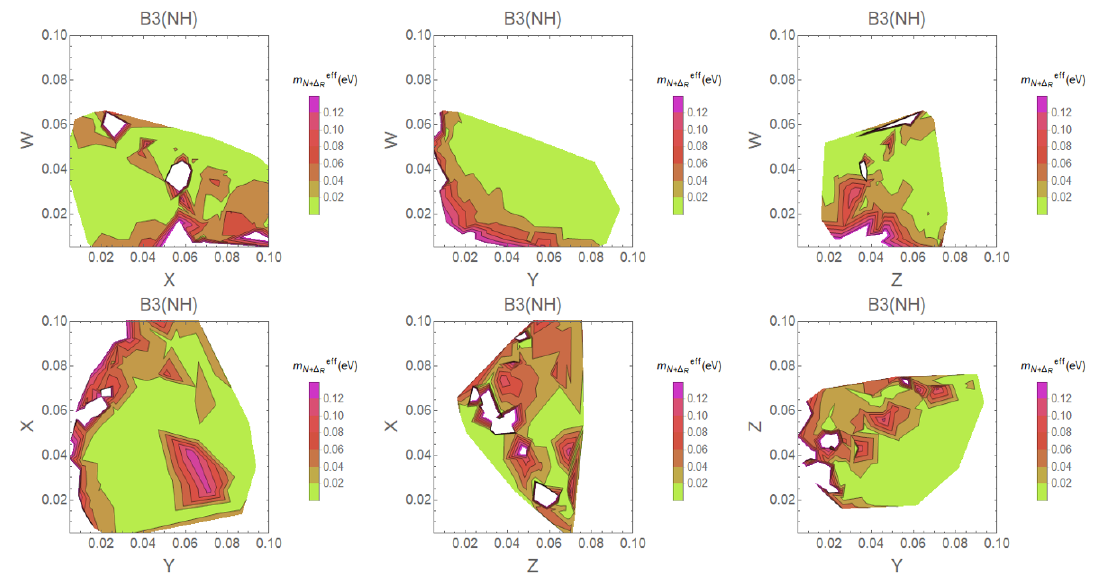
Figure 16 . The various combinations of type II SS model parameters (in eV) with the new physics contribution to e(cid:11)ective mass as the contour, where 0.061 eV is the KamLAND-Zen upper limit in B3 class of two texture zero neutrino mass matrix for normal hierarchy. Figure 17 . The various combinations of type II SS model parameters (in eV) with the new physics contribution to e(cid:11)ective mass as the contour, where 0.061 eV is the KamLAND-Zen upper limit in B3 class of two texture zero neutrino mass matrix for inverted